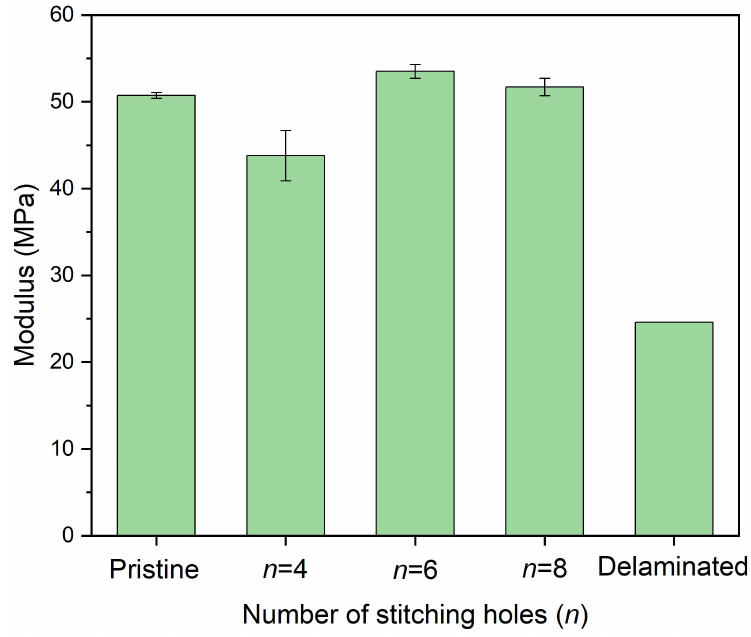
Figure 15. In-plane compressive modulus of delaminated plates after stitching repair with different numbers of stitching holes in which w = 0.8 and a 2.5 mm diameter were adopted.